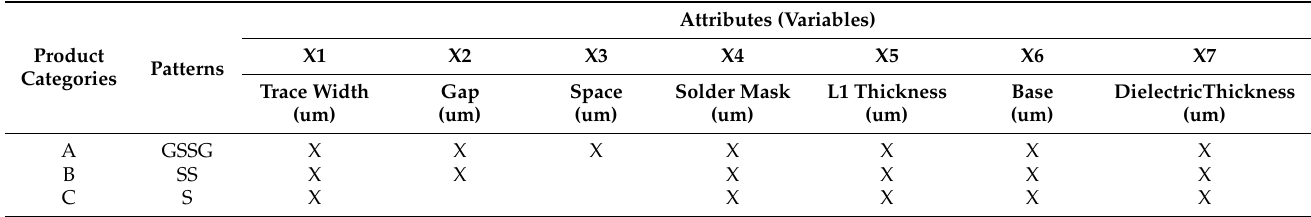
Figure 3. The architecture of forecasting impedance values by tree-based machine learning models with Optuna. Table 2. The corresponding attributes according to patterns’